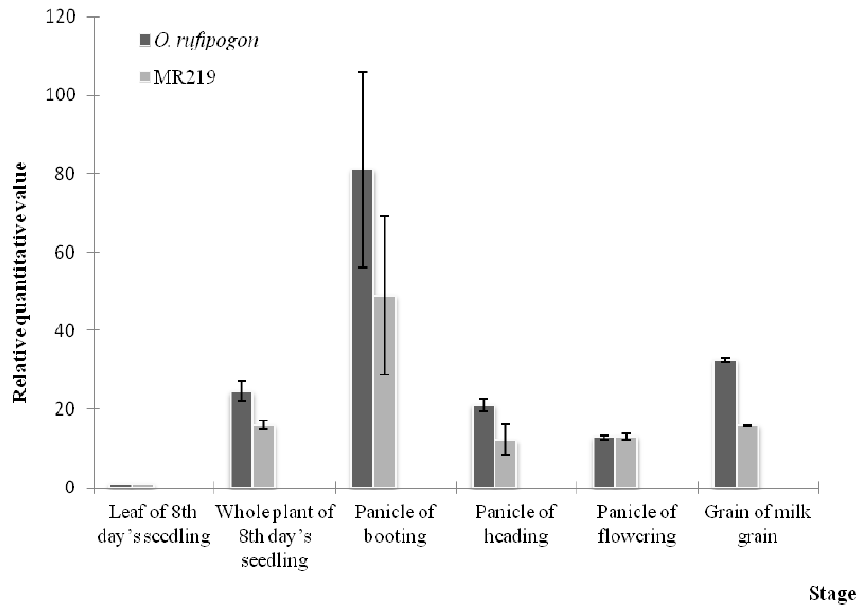
Figure 5. Comparative gene expression of OrufRPK1 and OsI219RPK1 during vegetative, reproductive and ripening phase. O. rufipogon and O. sativa ssp. indica cv. MR219 leaves and the whole plant were sampled at the seedling stage, the panicles at the booting, heading and flowering stages, and grains at the milk grain stage. Error bars indicate standard error of the